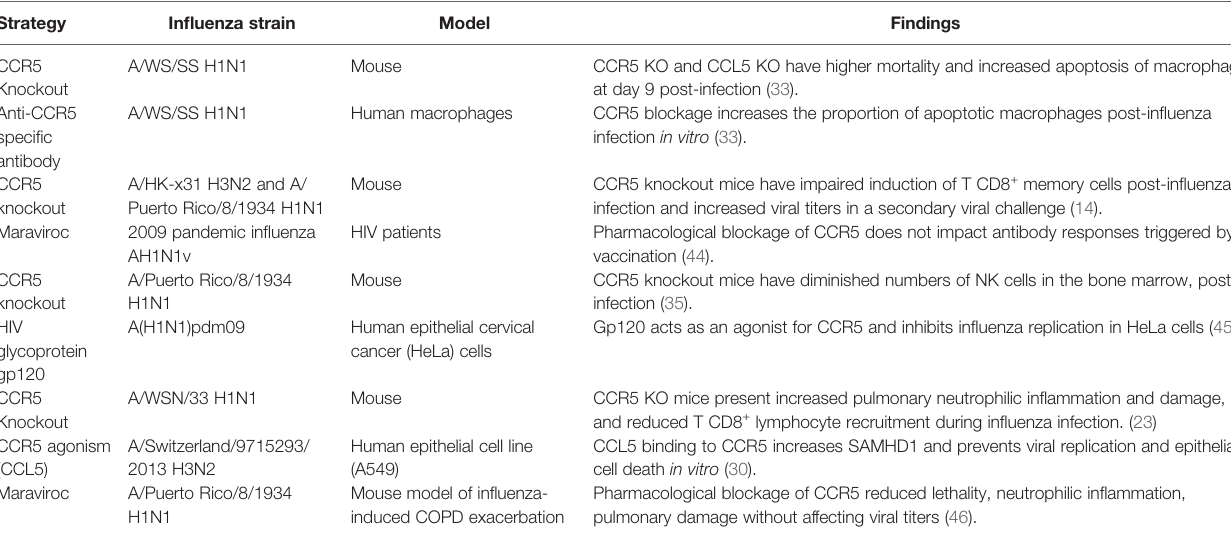
TABLE 1 | Evidence over CCR5 role on the immune response to in fl uenza virus. Strategy